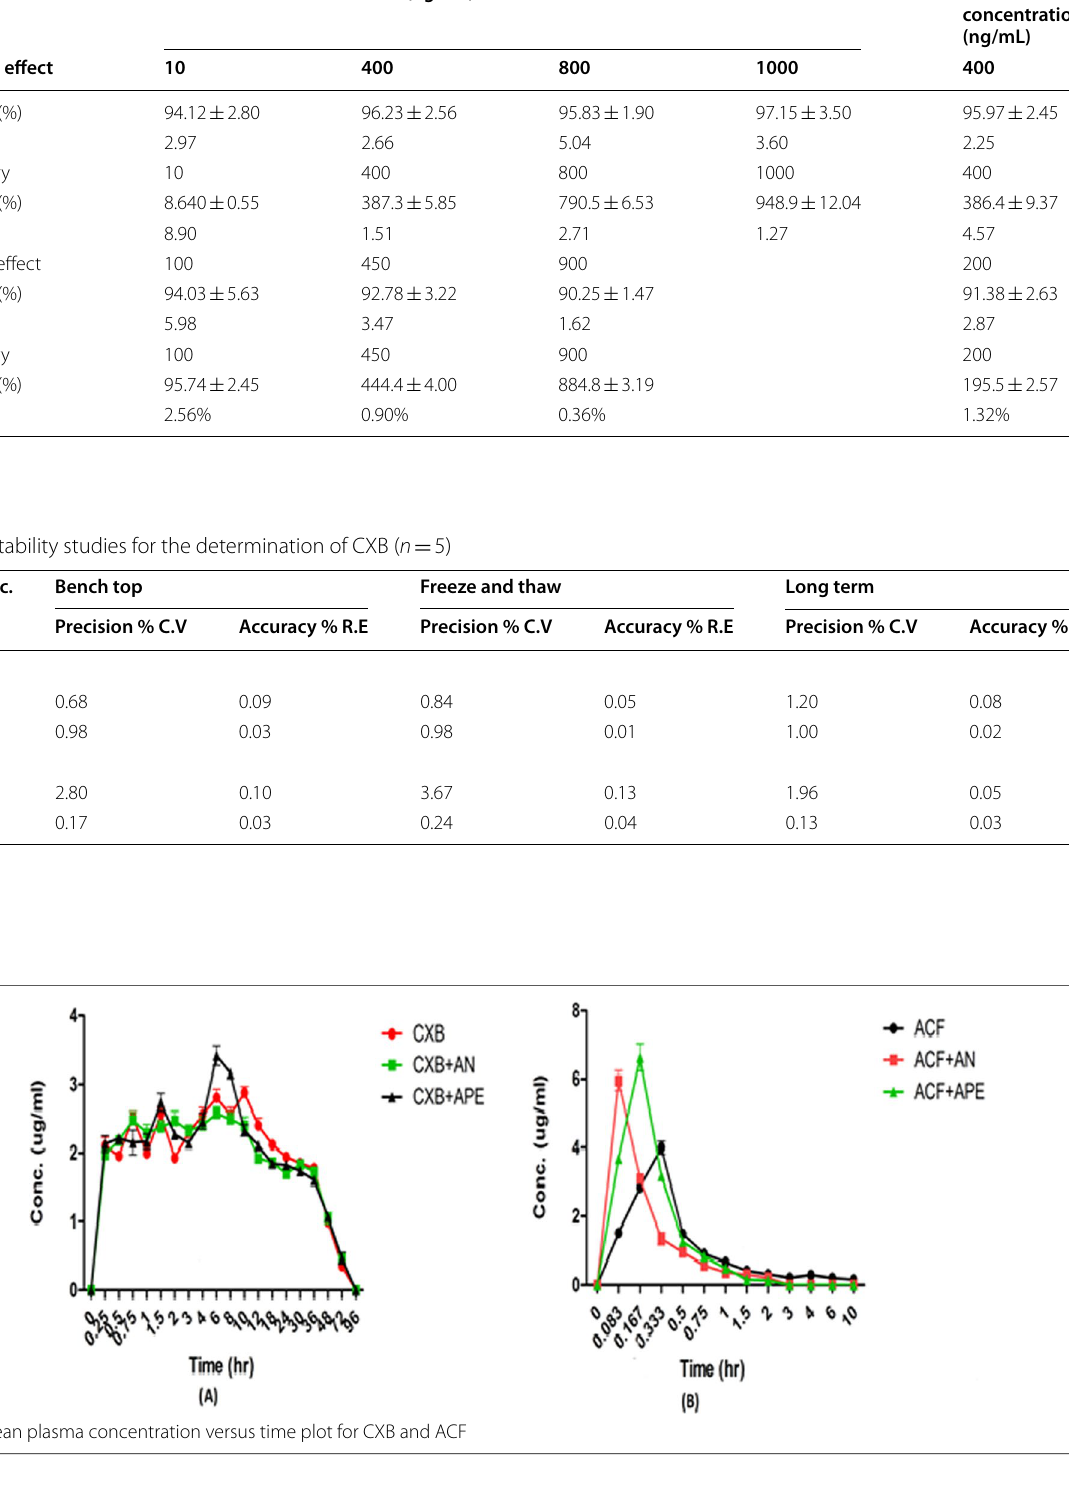
Table 3 Recovery and matrix effect of CXB and IS in rat plasma ( n Statistical variable